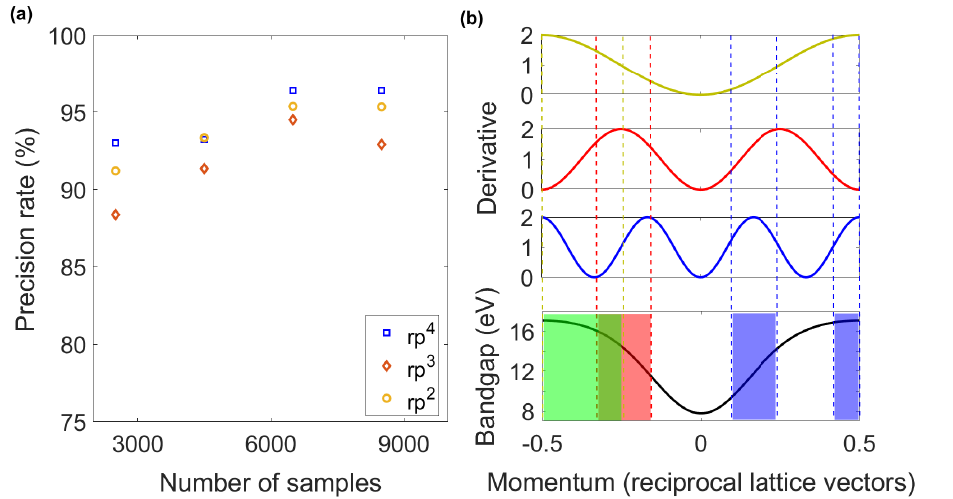
Figure 4. ( a ) Variation of the precision rate for rp 2 − rp 4 with the number of training samples. ( b ) From top to bottom, the derivatives of the band gap with respect to rp 2 − rp 4 and the band gap are shown, respectively. The colored area shows where each of the three parameters makes a major contribution to the band. For easier presentation, only the left or right half of each component contribution is